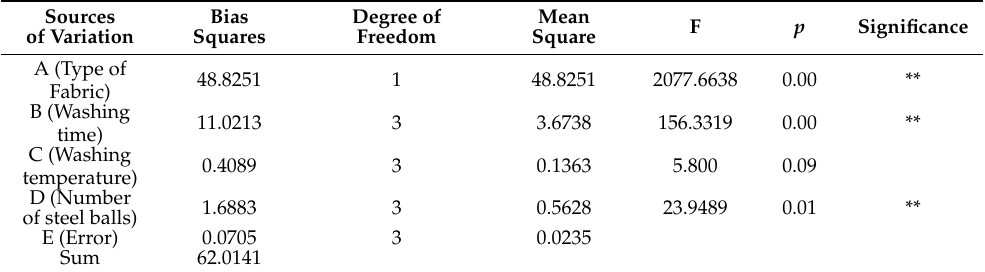
Table 8. Variance analysis of fabric type and washing